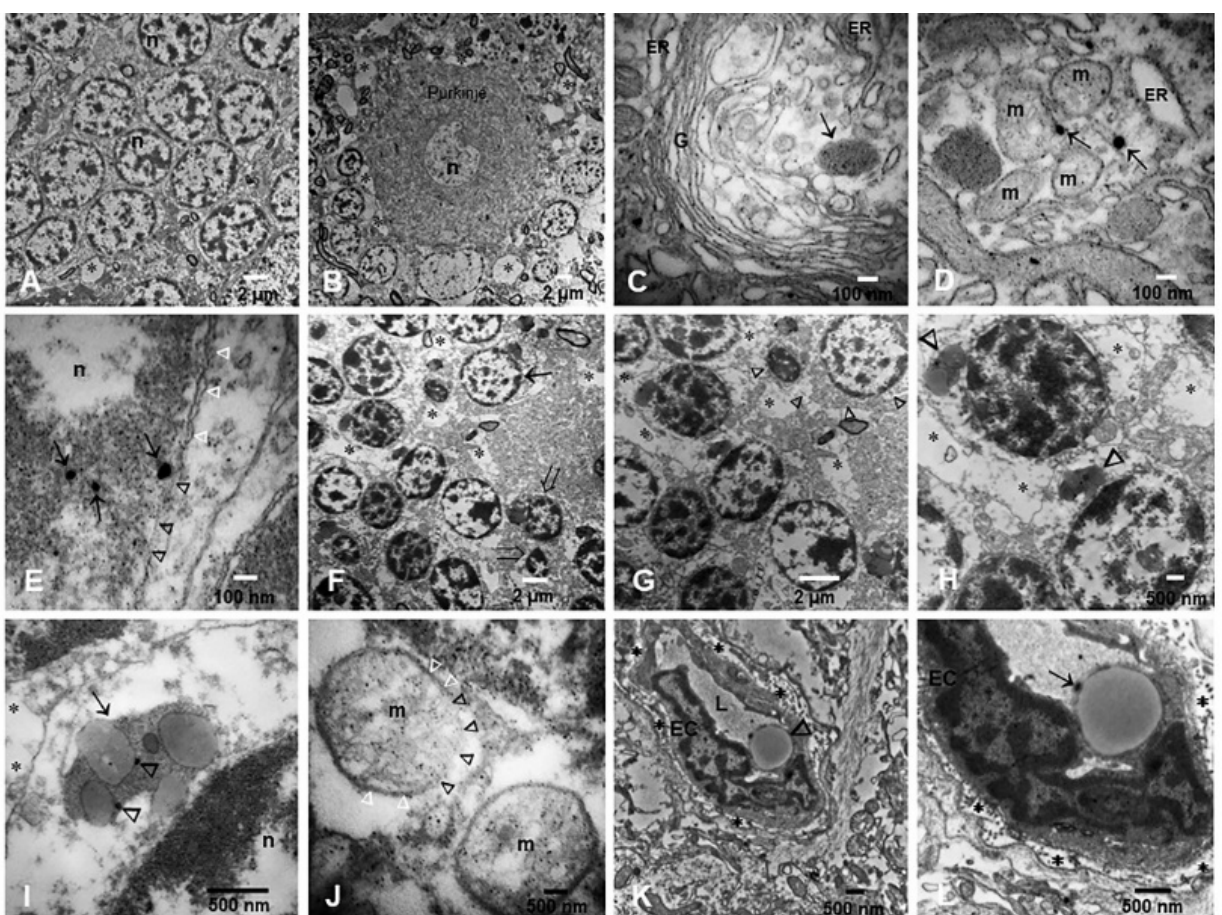
Figure 3. TEM in cerebellum. ( A ) Granular layer neurons in a 3 year-old male. A few, vacuolar spaces are seen between neurons. ( B ) One Purkinje cell is surrounded by glial and neuronal bodies. There is a significant number of vaculated spaces (*), particularly towards the molecular layer (upper third) where axons are identified. Same 3 year-old as ( A ). ( C ). Close-up of Golgi apparatus and dilated endoplasmic reticulum (ER) in a MMC 11 year-old child. Notice the lysosomal structure with nanoparticles (arrow). ( D ). Purkinje neuron cytoplasm exhibiting mitochondria with abnormal cristae and two distinct spherical NPs (arrows). The ER is markedly dilated. ( E ). Fourteen-year-old Purkinje cell nucleus with three spherical NPs (arrows) in the midst of heterochromatin. The double nuclear membrane is apparently intact along the white arrow heads but disappears under the black arrow heads. ( F ). Granular cell layer in a 36 year-old male shows a significant number of neuropil vacuolated areas (*) and a marked contrast between an apparently intact nucleus (arrow) and two nuclei with chromatin condensation, nuclear shrinkage, and the formation of apoptotic bodies (opened arrows). ( G ). A close-up of (F) shows the empty spaces between neurons (*) and the large lysosomal bodies (arrow heads) in the granular cells, seen also in ( H ). ( H ) These two neurons have already marked cytoplasmic changes with fragmented organelles and ill-defined cell membranes. ( I ). A conglomerate of lysosomal structures (arrow) with NPs (arrow heads). ( J ) In the same sample, two mitochondria with ill-defined membranes (black arrow heads) and apparently intact double membranes (white arrow heads). ( K ). Cerebellar blood vessel in a 45 year-old male with significant vacuolization and fragmentation of the perivascular neuropil (*). Notice the endothelial cell (EC) and the vessel lumen. ( L ) A close-up of the same vessel to show the erythrophagocytosis of the endothelium. The arrow points to a NP trapped between the erythrocyte engulfed by the endothelial cell and the endothelial coverture. The multiple *s point to the NVU breakdown.